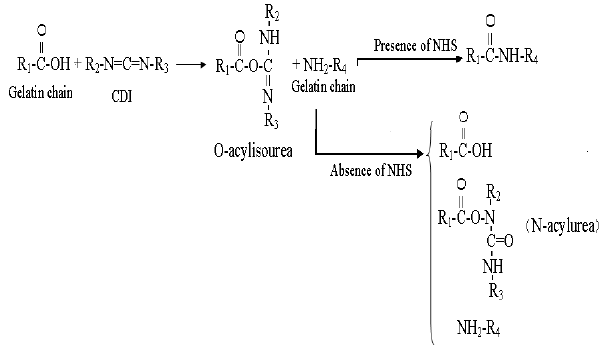
Fig. 2. Cross-linking mechanism of CDI/NHS